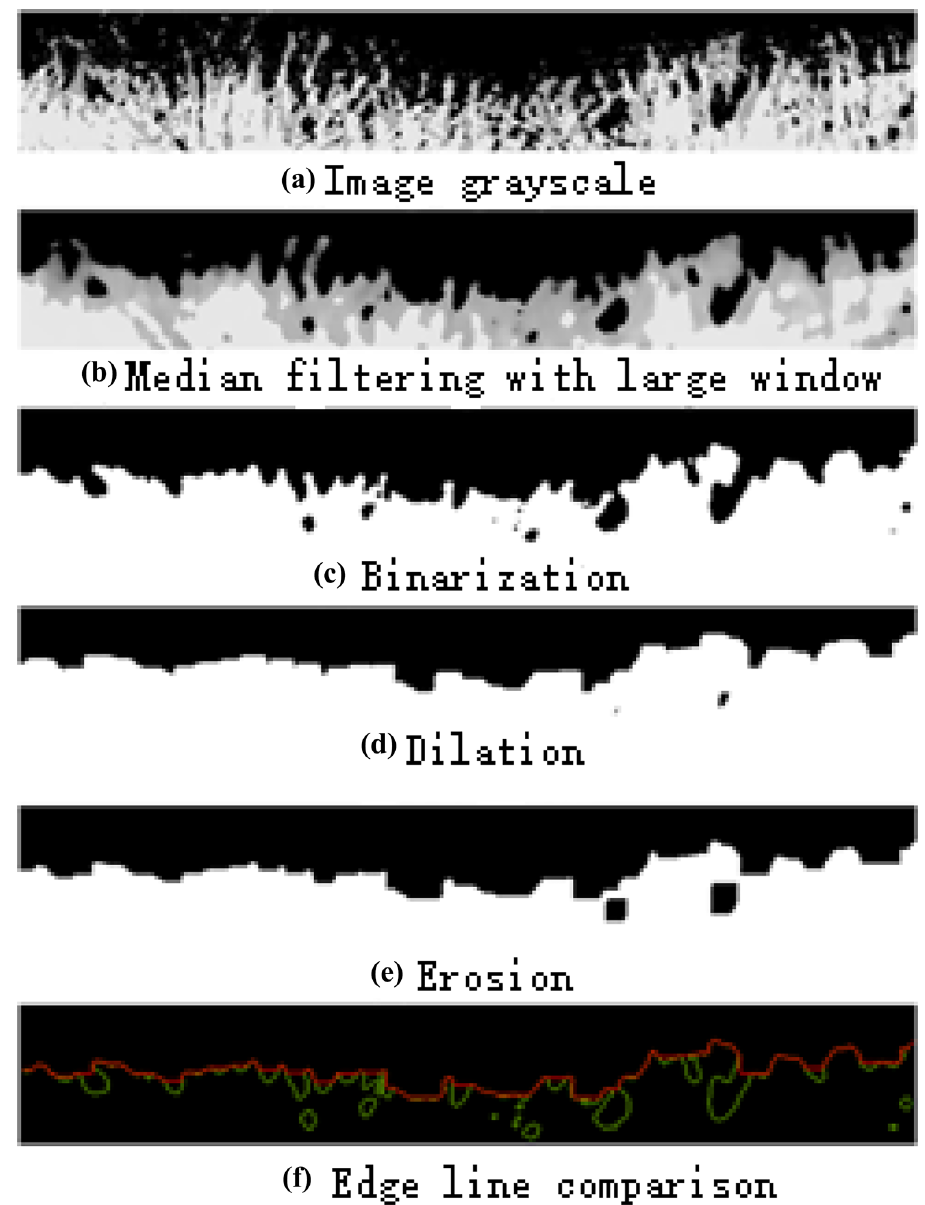
Fig. 6 Acquisition of upper boundary